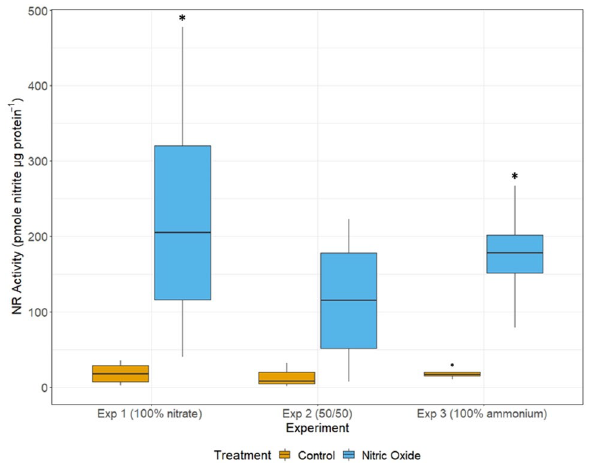
Figure 3. Nitrate reductase enzyme activity in Heterosigma akashiwo after spiking with NO. Nitrate reductase (NR) enzyme activity 2 h after spiking with NO for Control and treatment Heterosigma akashiwo cultures when acclimated to growth on 100 µM nitrate (Exp 1), 50 µM nitrate and 50 µM ammonium (Exp 2), or 100 µM ammonium (Exp 3). Expression was normalized to protein content. Error bars are + /− 1 standard deviation from the mean. Significant difference in activity in the nitric oxide treatment compared to controls (*) is denoted.